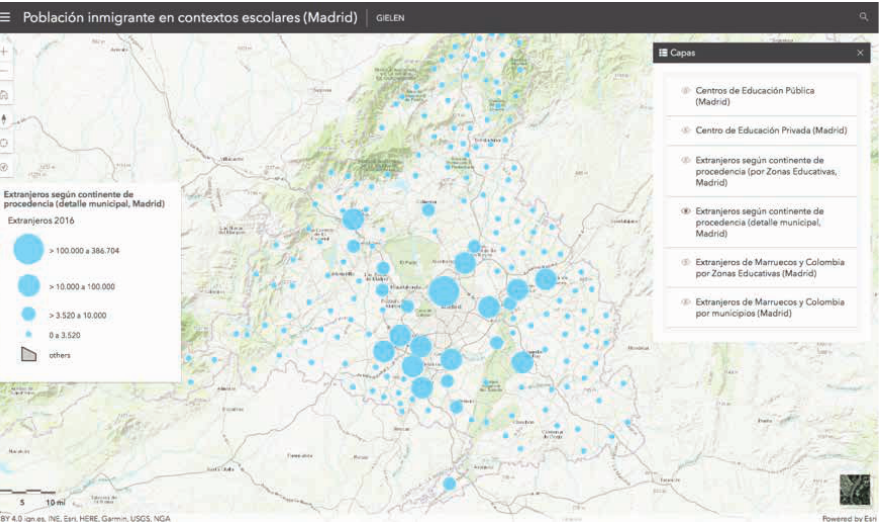
Figure 5: Sample of sociodemographic study performed using the Web Mapping Application “Immigrant population in educa- tional contexts”